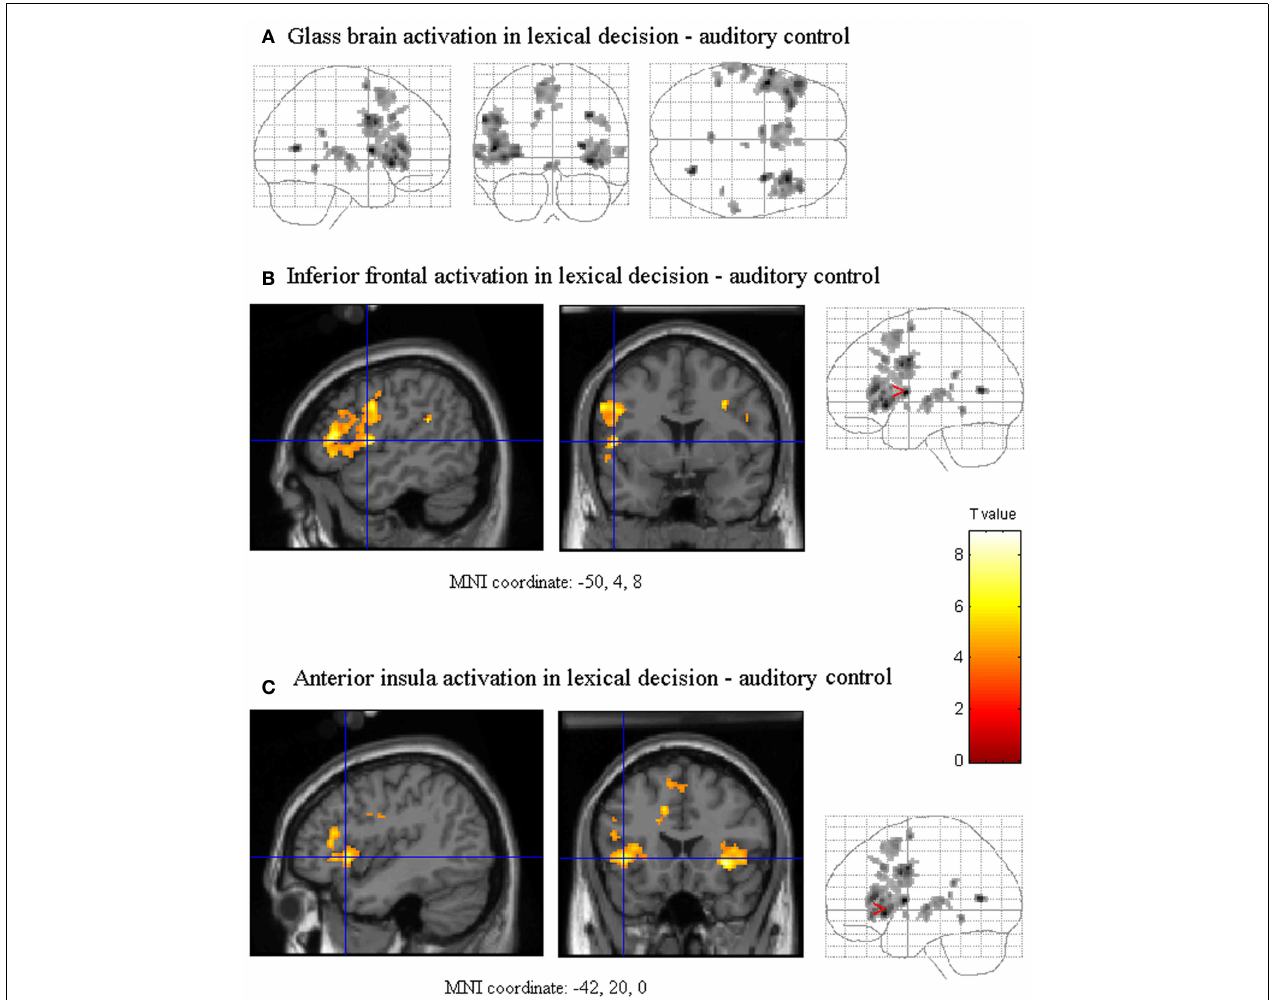
FIGURE 6 | Brain regions activated in the auditory modality in the lexical decision compared to the auditory control task. Glass brains are presented in (A) . (B,C) Show activation in the left IFG and left anterior insula, respectively.